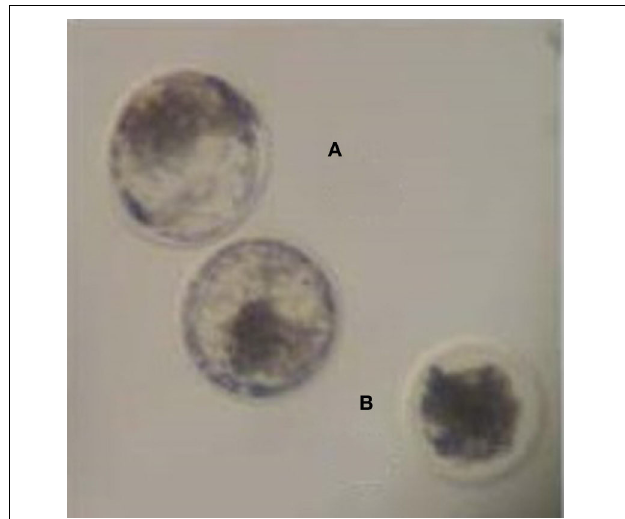
FIGURE 1 | Day 8 morphological assessment of embryos. (A) Blastocyst embryos. (B) Degenerate embryo.